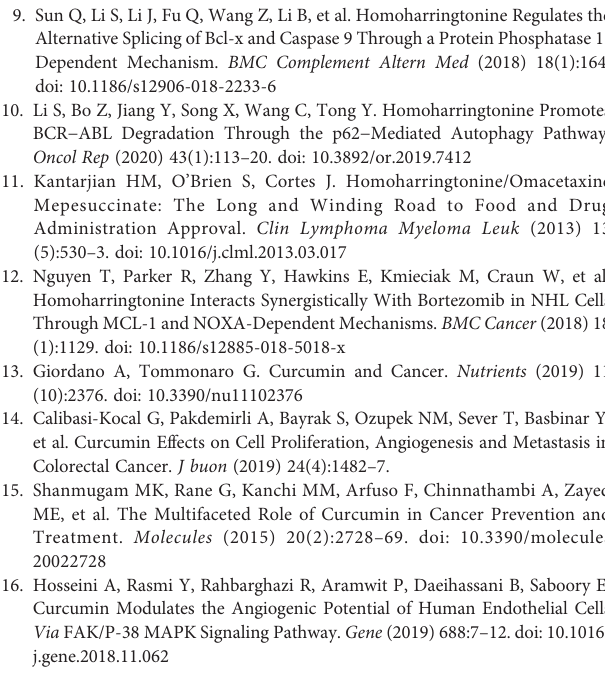
Supplementary Figure 3 | Combination of curcumin with HHT upregulated the levels of miR-150, miR-22, miR-206 and miR-34a in Raji cells. RT-qPCR analysis of miR-150, miR-22, miR-206 and miR-34a levels in Raji cells treated with 5 ng/mL HHT and 10 m M curcumin. ** P < 0.01 compared with control group. Supplementary Figure 4 | Interactions with the microenvironment could protect Rajicellsfromcombinationtreatment-inducedapoptosis.resistance.Rajicellswereco- cultured on a con fl uent monolayer of HS-5 stromal cells for 24 h. Then, Raji cells were treatedwith5ng/mLHHTand10 m Mcurcuminforanother72h. (A)